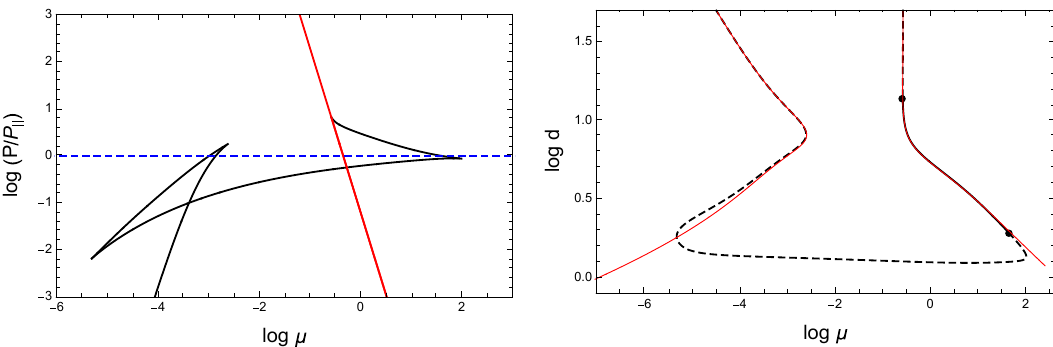
Figure 2 . Left panel: pressure of the baryonic phase (black solid), mesonic phase (straight red solid line), and chirally symmetric phase (blue dashed horizontal line), all normalized to the pressure of the chirally symmetric phase P . Right panel: instanton distance over instanton width d as a jj function of (cid:22) for the baryonic phase. The (black) solid segment corresponds to the stable phase, while the dashed segments are unstable or metastable. The thin (red) curves are the results with non-interacting instantons.